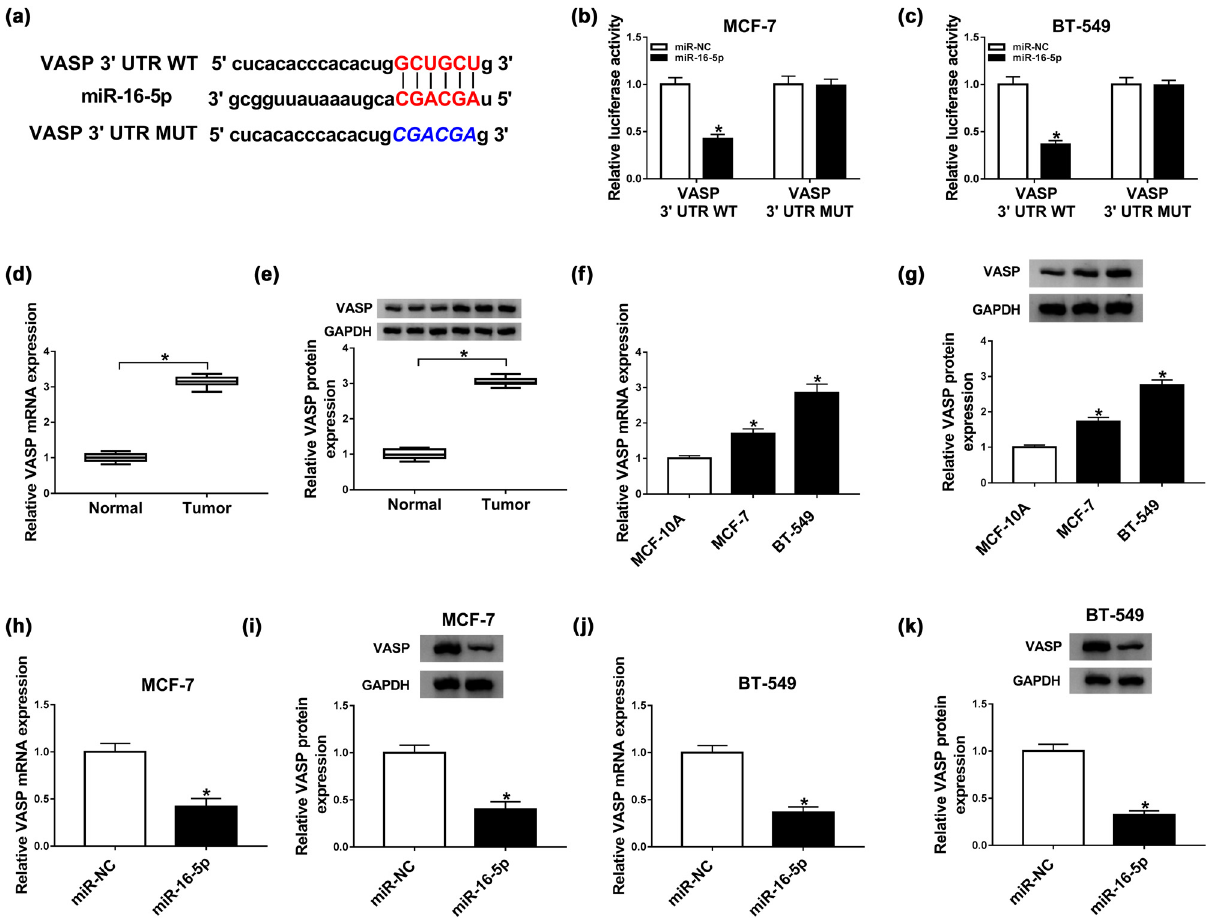
Figure 5: VASP was a direct target of miR - 16 - 5p. ( a ) Schematic of sequence complementarity between miR - 16 - 5p and VASP 3 ′ - UTR and the mutant in complementary sequence. ( b and c ) The luciferase activity in MCF - 7 and BT - 549 cells cotransfected with VASP 3 ′ - UTR wild - type reporter ( VASP 3 ′ - UTR WT ) or site - directed mutant of the target sequence ( VASP 3 ′ - UTR MUT ) and miR - NC mimic or miR - 16 - 5p mimic. The mRNA and protein levels of VASP in 22 pairs of BC tissues and adjacent normal breast tissues ( d and e ) , MCF - 10A, MCF - 7, and BT - 549 cells ( f and g ) , MCF - 7 ( h and i ) , and BT - 549 ( j and k ) cells transfected with miR - NC mimic or miR - 16 - 5p mimic. * P <